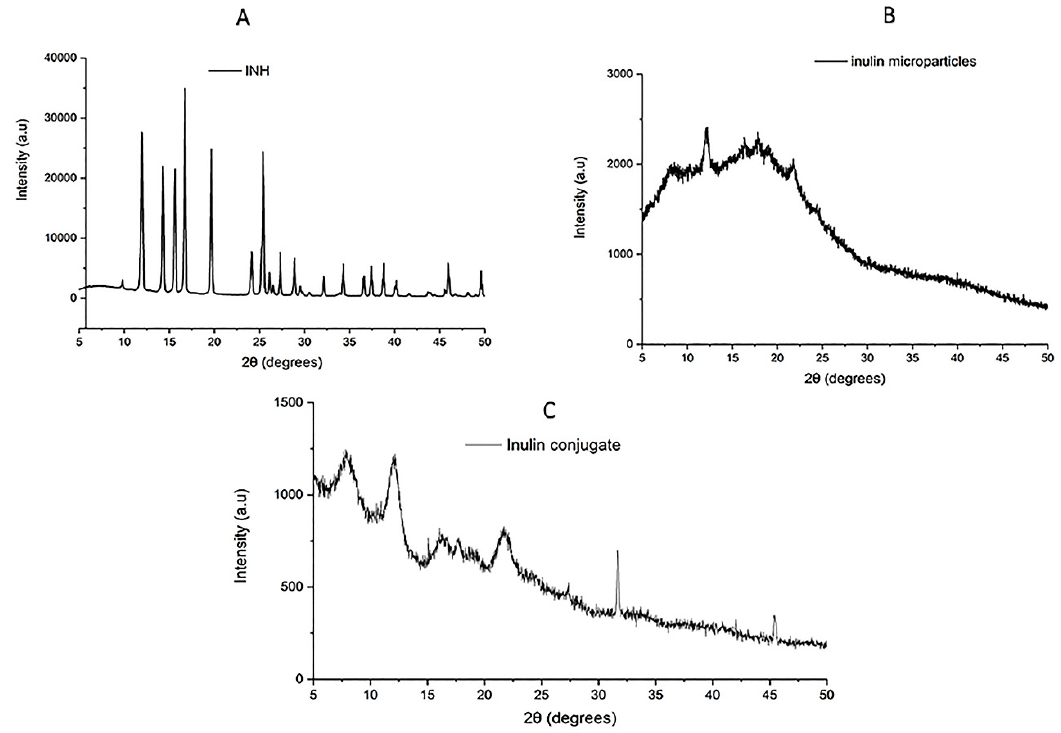
Figure 3. X-ray powder diffraction (XRD) diffraction graph of INH ( A ), inulin ( B ), and conjugate ( C ).